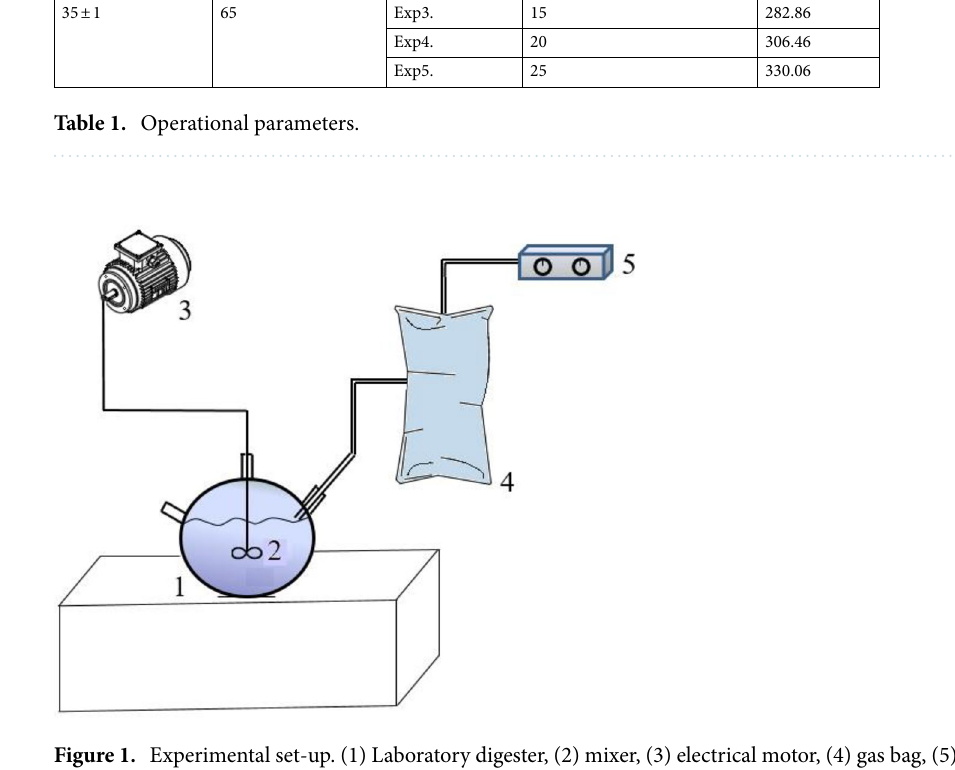
Figure 1. Experimental set-up. (1) Laboratory digester, (2) mixer, (3) electrical motor, (4) gas bag, (5) gas